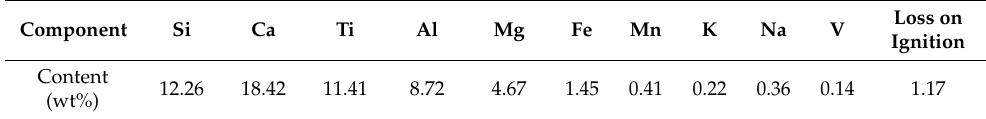
Table 2. XRF analysis of TCS.